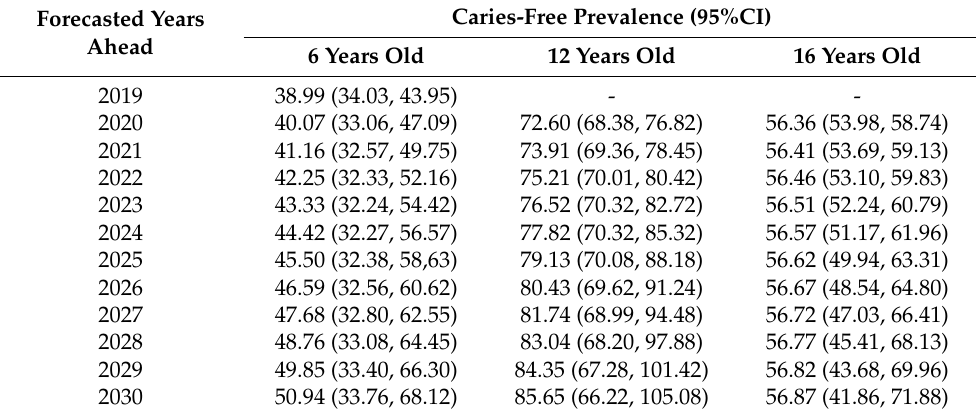
Figure 2. Univariate projection of caries-free prevalence among 6-, 12- and 16-year-old schoolchildren. Table 4. Forecasted cases of caries-free among 6-, 12- and 16-year-old schoolchildren over ten-year time period from 2019 to 2030.